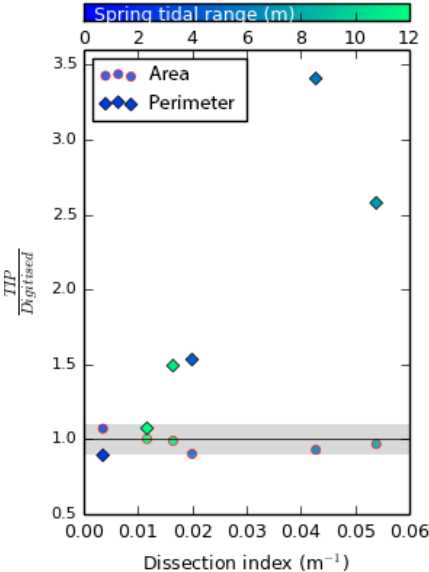
Figure 11. Ratio of TIP over digitised area (circles, red outlines) and perimeter (diamonds, black outlines) for sites S1 to S6 at the native resolution of 1m, with no Wiener filtering, as a function of dissection index. Here, dissection index is defined as the ratio of the total length of tidal channels within the digitised marsh platform over the area of the digitised marsh platform and is not bounded by drainage basins. The greyed area corresponds to a 10% buffer around the line of equation y = 1.